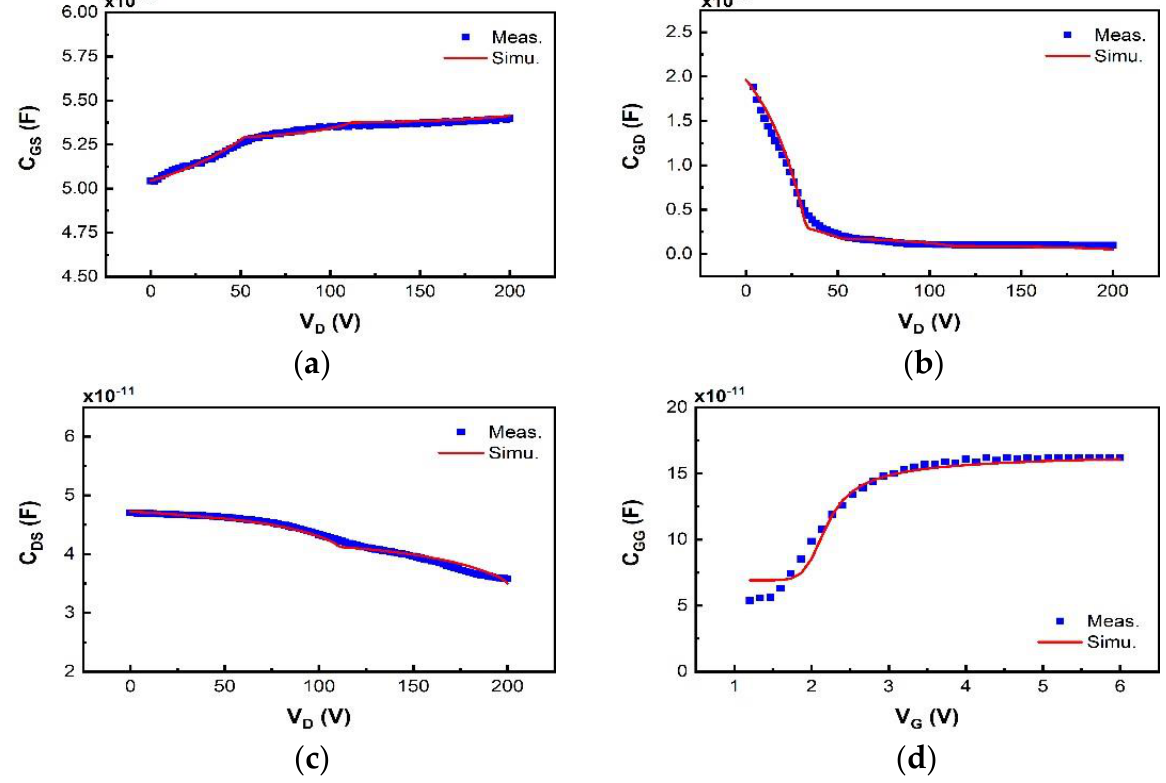
Figure 5. The C–V characteristics of the surface potential (SP) model (line) are compared with measurement data (dot) as a function of input voltage: ( a ) C DS at different V D ; ( b ) C GD at different V D ; ( c ) C GS at different V D ; ( d ) C GG (= C GS + C GD ) at different V G .